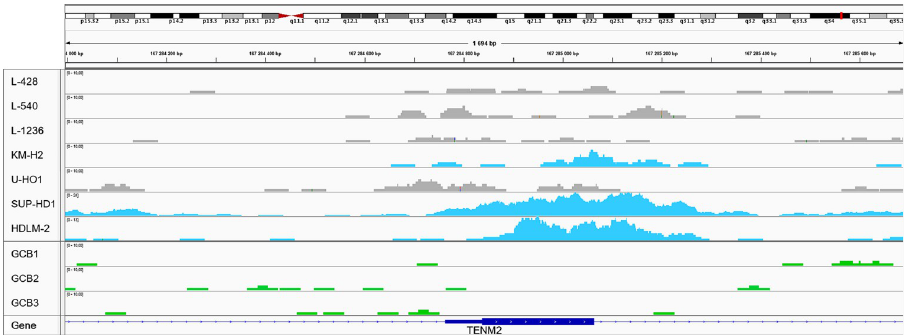
Fig 6. TENM2 ChIP-seq results in cHL cell lines and GCBs. The visualisation (IGV) [47] of ChIP-seq (H3K27ac) experiment performed on 7 cHL cell lines and 3 GCB cell pools (left panel). The 27 th lysine acetylation for TENM2 promoter region shows higher chromatin activity in KM-H2, SUP-HD1 and HDLM-2 cHL cell lines (blue peaks). Grey peaks represent cHL cell lines with less activated chromatin, whereas chromatin is closed in the GCB controls (green peaks).